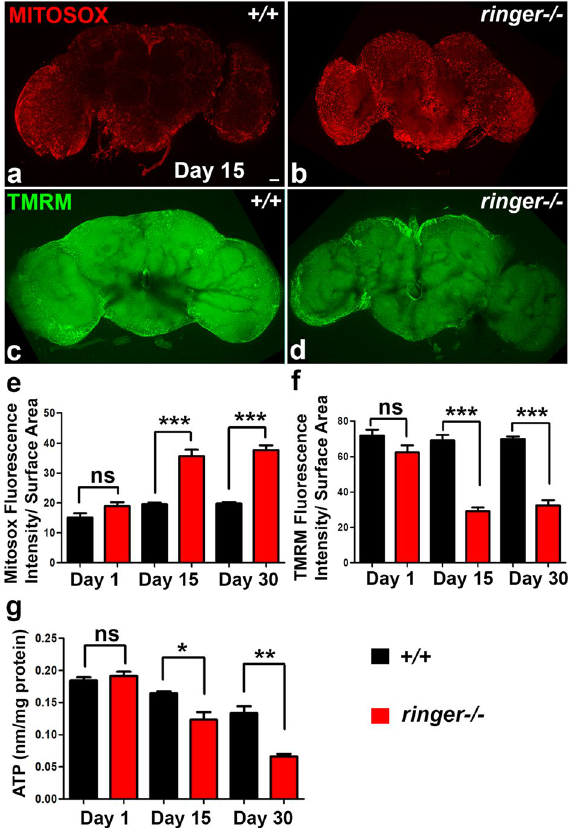
Figure 5. Ringer mutants show mitochondrial dysfunctions. ( a , b ) MitoSOX red fluorescence in day 15 whole- mount adult brain preparations from wild type ( a ) and ringer −/− ( b ) flies. ( c , d ) TMRM green fluorescence in day 15 whole-mount brain preparations from wild type ( c ) and ringer −/− ( d ) flies. ( e , f ) Quantification of fluorescence intensity of MitoSOX ( e ) and TMRM ( f ) normalized to the surface area of the brains from wild type (black) and ringer mutants (red) from day 1, 15 and 30 flies. Scale bar in ( a - d ) = 20 µm and n = 7 brains per genotype. ( g ) Analysis of ATP levels in day 1, day 15 and day 30 flies of wild type (black) and ringer −/− (red). n = 3 (each experiment was done independently three times). Statistics were done using unpaired student’s t test. ( e ) day1 p = 0.0896, day15 *** p < 0.0001, day30 *** p < 0.0001, ( f ) day1 ns p = 0.1086, day15 *** p < 0.0001, day30 *** p < 0.0001 and ( g ) day 1 ns p = 0.4445, day15 * p = 0.0283, day30 ** p =